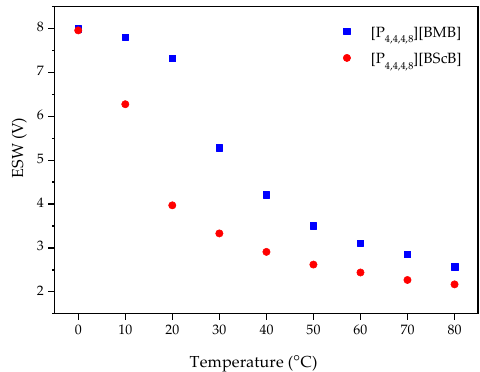
Figure 7. ESWs as a function of temperature for the ILs using a GC electrode.